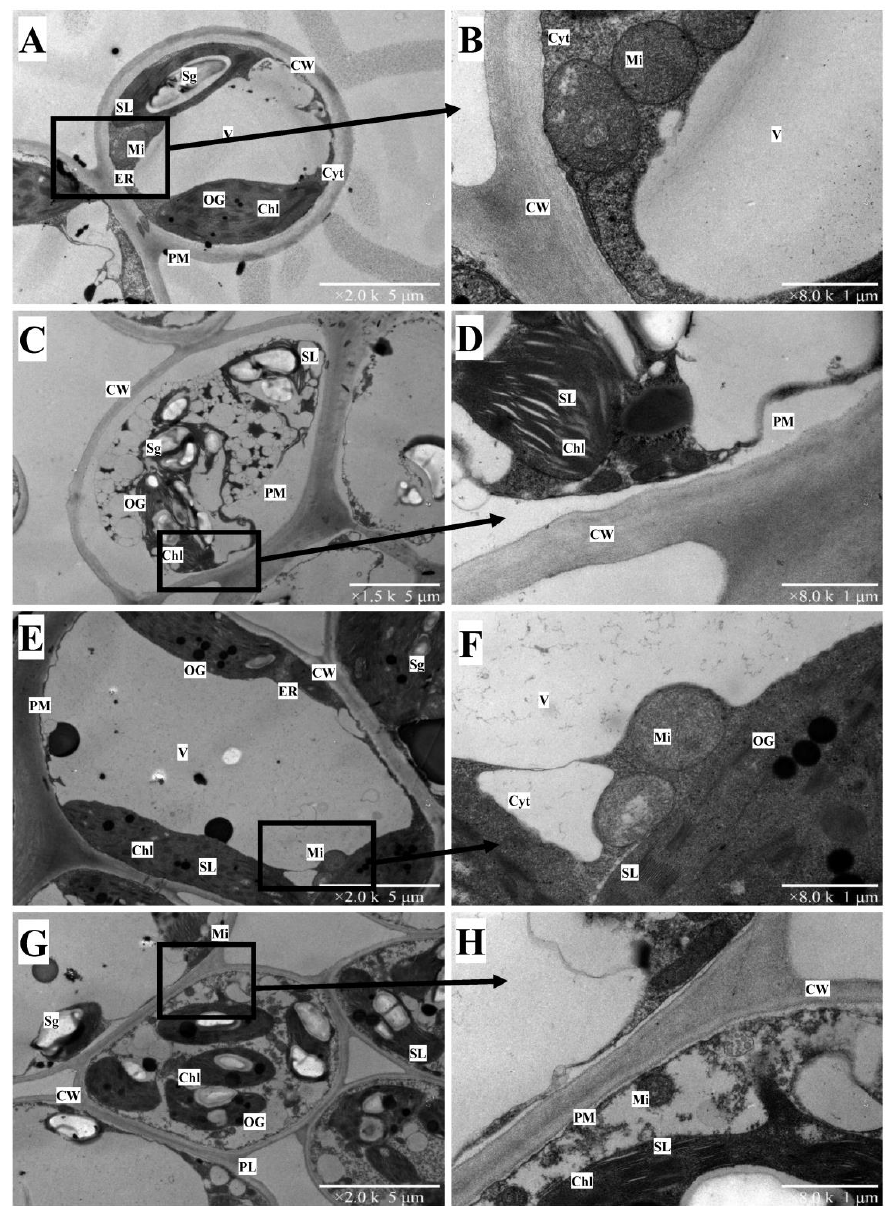
Figure 5. The TEM images of 0.5 µM ( A , B , E , F ) and 300 µM Cu-treated ( C , D , G , H ) leaves of two citrus species. C. sinensis : ( A – D ); C. grandis : ( E – H ). The right figures are partial enlargements of the left figures. Chl: chloroplast; CW: cell wall; Cyt: cytoplasm; ER: endoplasmic reticulum; Mi: mitochondrion; OG: osmiophilic globule; PM: plasmalemma; Sg: starch granules; SL: stroma lamella; V: vacuole. The scales in figures ( A , C , E , G ) represent 5 μm. The scales in figures ( B , D , F , H ) represent 1 μm.